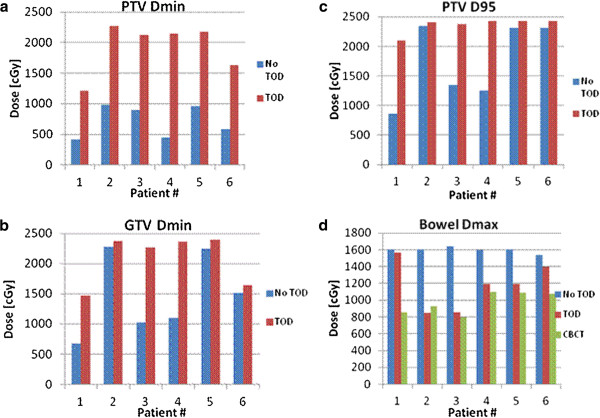
Dosimetric outcomes with temporary organ displacement (TOD), bowel. The bar graphs reflect pre-TOD dosimetry (blue), post-TOD dosimetry (red), and dose delivered by cone beam computed tomography (green). (a) Planning target volume (PTV) Dmin, (b) gross tumor volume (GTV) Dmin, (c) PTV D95, (d) bowel Dmax.